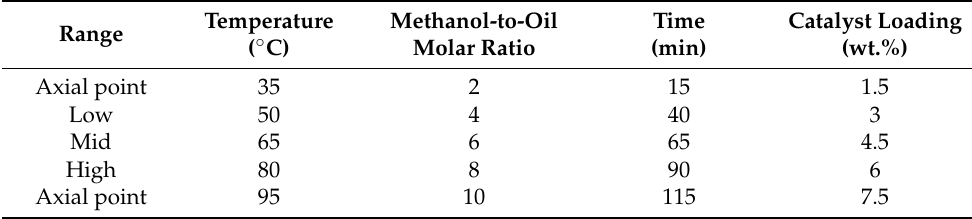
Table 1. Process parameters for biodiesel and its experimental ranges.